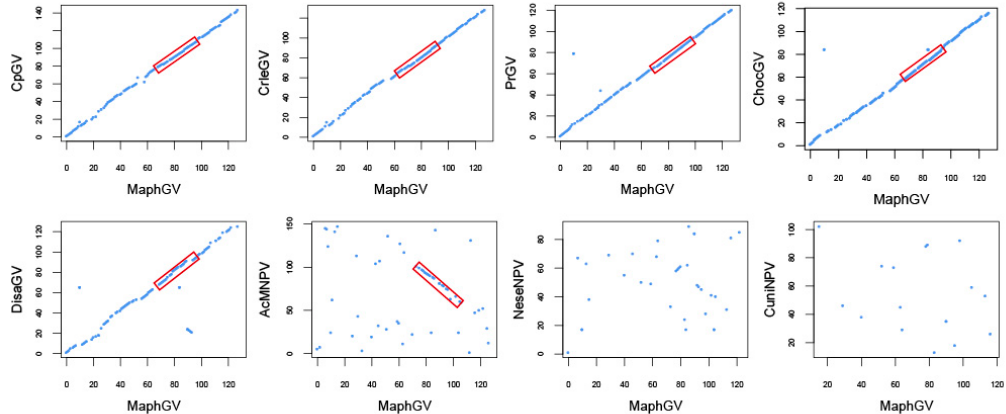
Figure 4. Gene parity plots comparing MaphGV with other baculoviruses. The ORF content and order of the MaphGV genome (x-axis) was compared with that of CpGV, CrleGV, PrGV, ChocGV, DisaGV, AcMNPV ( Alphabaculovirus ), NeseNPV ( Gammabaculovirus ), and CuniNPV ( Deltabaculovirous ) (y-axes). Each point in the plot represents a MaphGV ORF homolog found in other baculoviruses. The red boxes indicate the lepidopteran baculovirus collinearly conserved regions.